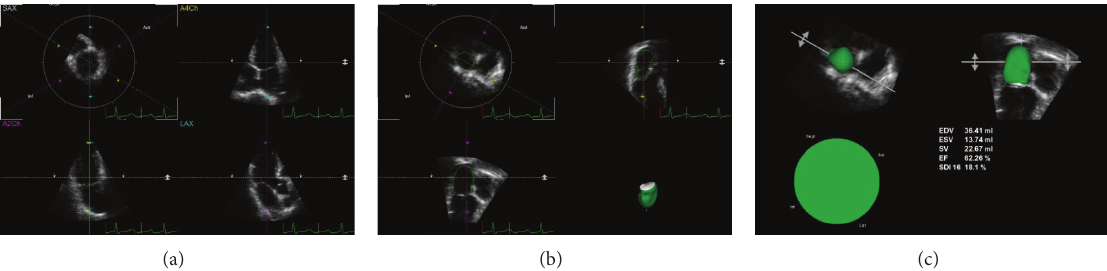
Figure 8: Left atrial volumes by TomTec 4D echocardiography. (a) After LA full-volume data acquisition, TomTec software displays LA in 3 different apical planes (4-chamber; 2-chamber, long-axis). (b) The endocardial border is surrounded on end-diastolic and end-systolic frames and, if needed, manually corrected. (c) Atrial maximum (max) and minimum (min) volumes are obtained using semiautomated border detection algorithm and displayed in numeric values and in 3D image (in